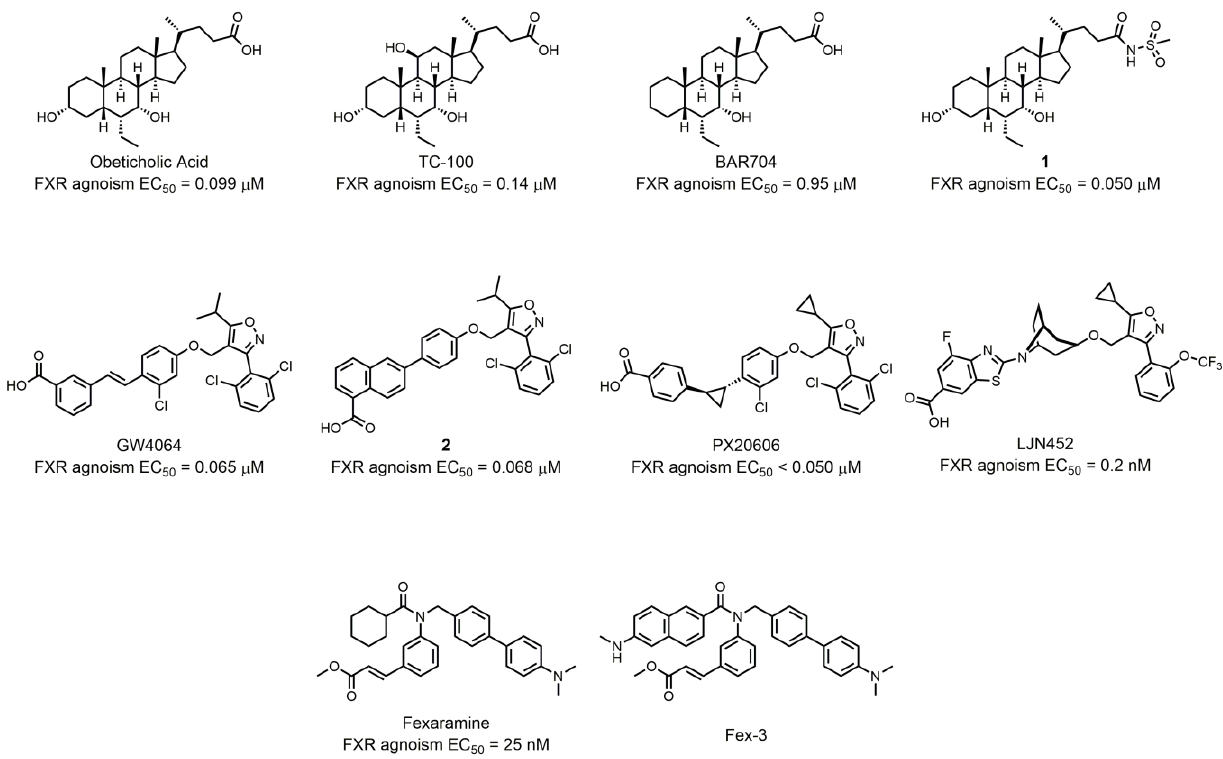
FIGURE 2: Semisynthetic bile acid derivatives as FXR agonists and synthetic FXR